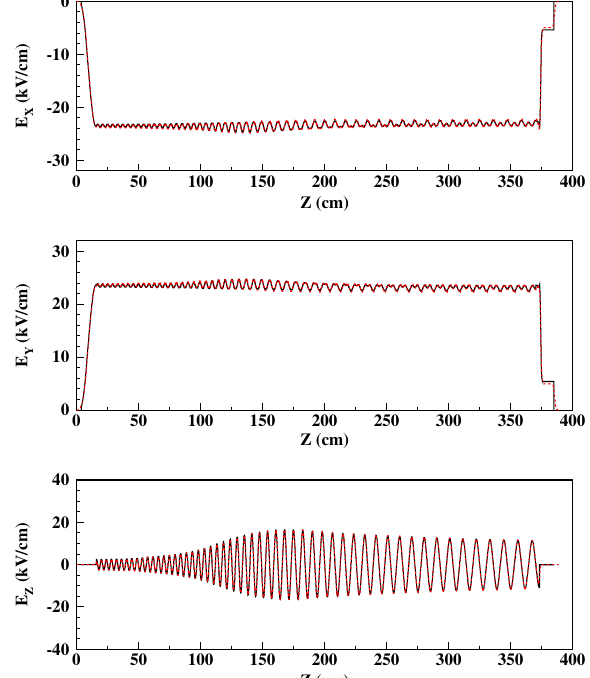
FIG. 6. Comparison of the electric field components along the RFQ at mid aperture between the eight-term potential (solid black) and the cell-by-cell 3D model (dashed red) of the original sinusoidal design. The almost perfect superposition of the curves reflects the good